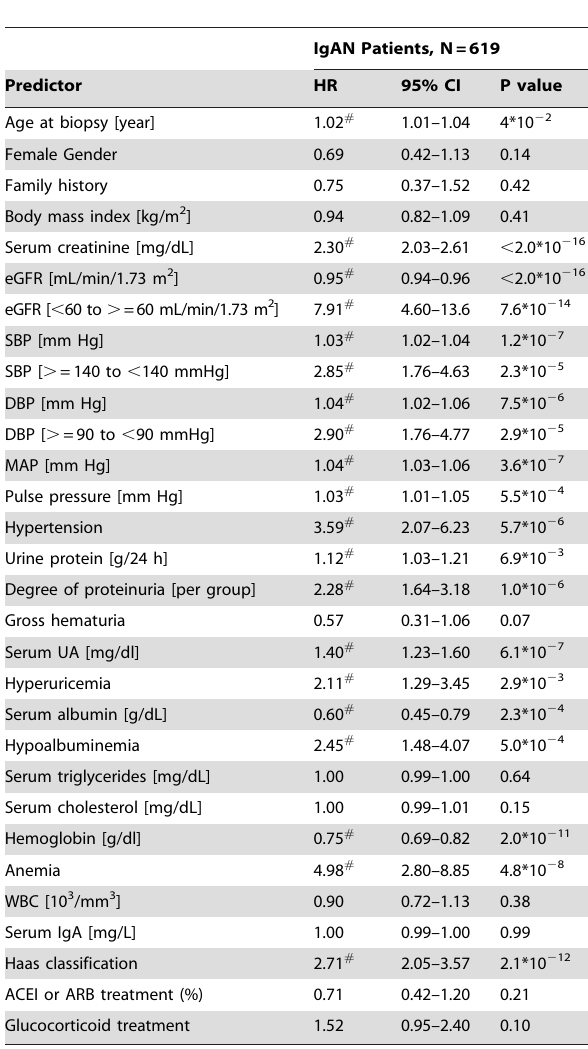
Table 1. Baseline characteristics of IgAN patients. Table 2. Univariate analysis of baseline variables with renal end points for